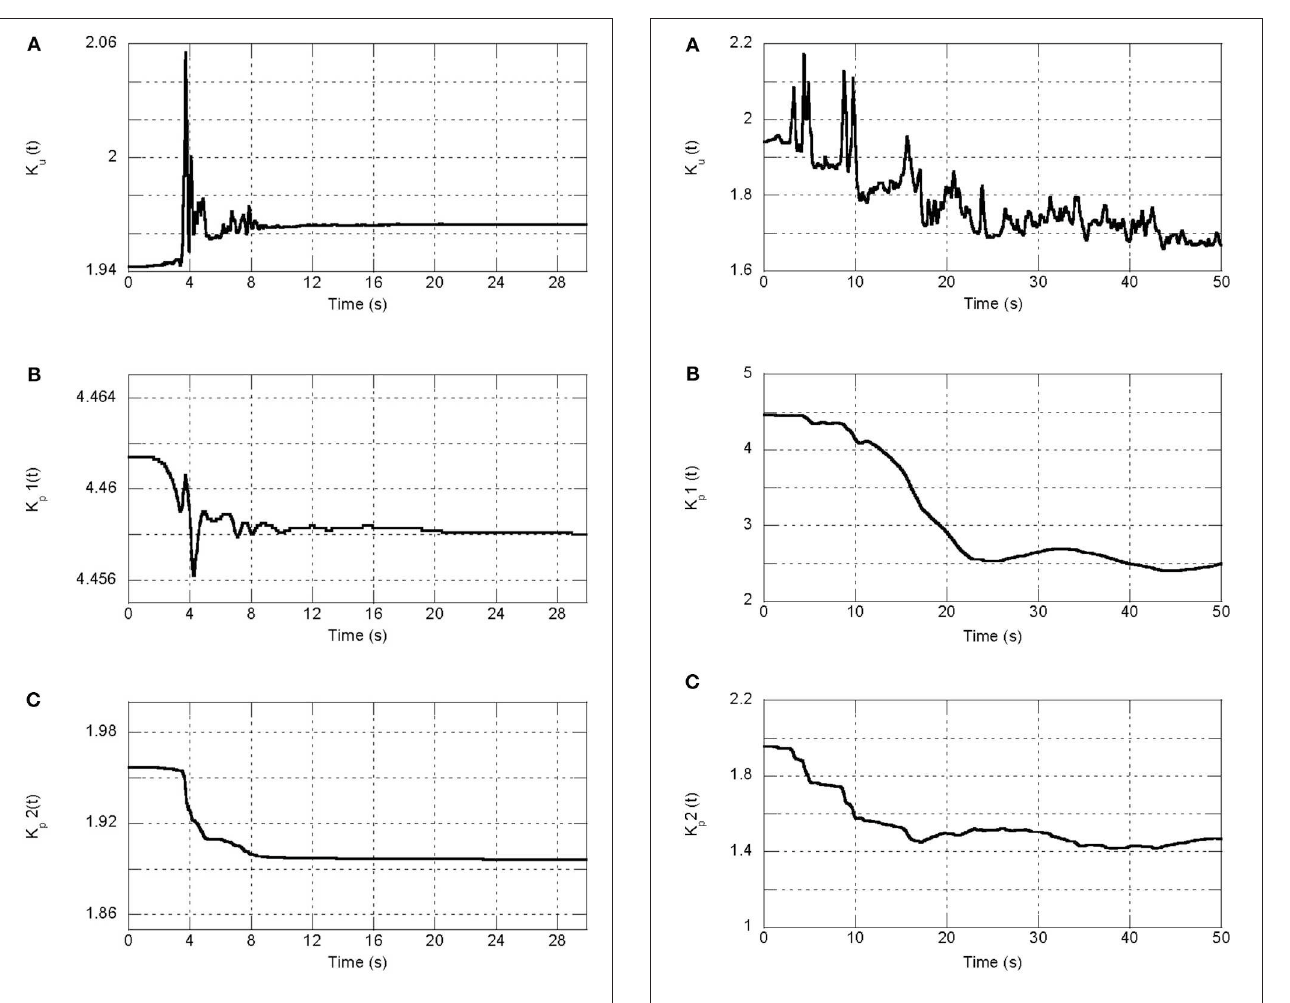
FIGURE 8 | Adjustment of MRAC controller parameters for the Northridge earthquake. (A) Adjustment of K u [ e y ( t ), t ] . (B,C) Adjustment of K p [ e y ( t ) , t ] .